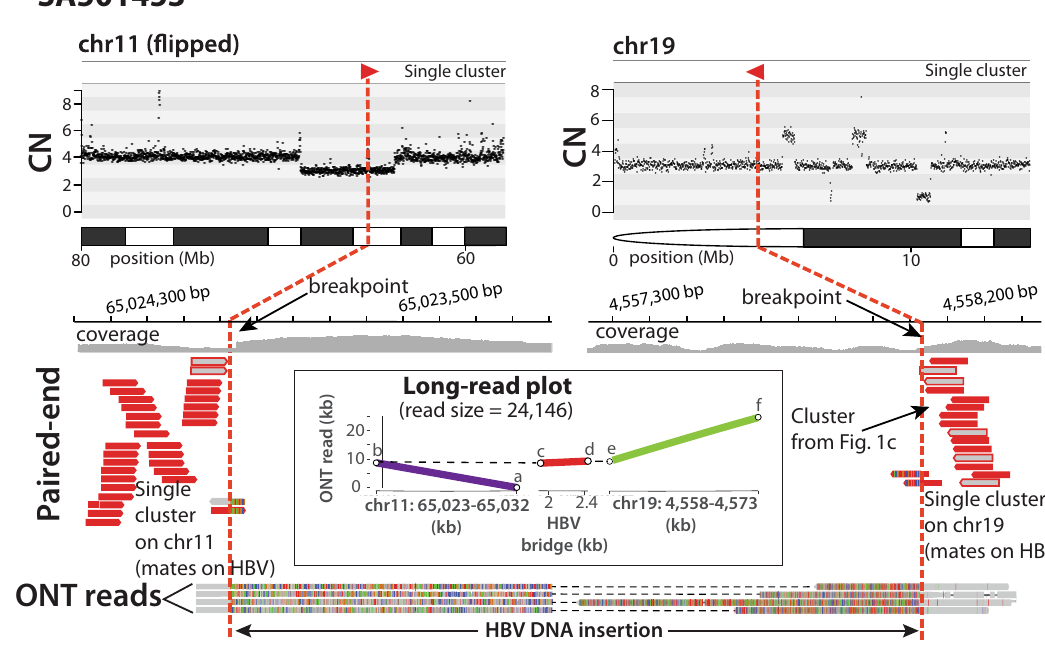
Fig. 2 Long-read sequencing reveals cryptic HBV-mediated translocations in human HCC. In HCC SA501453, a hidden interchromosomal rearrangement between chromosomes 11 and 19 is identi fi ed using Oxford Nanopore Technologies (ONT). The copy number plot (CN) at the top shows the copy number pro fi les of the chromosomes involved in the rearrangement (note that the CN plot on chromosome 11 is fl ipped for illustrative purposes). The Illumina paired-end sequencing data (short-reads in red) shows two single clusters of discordant read pairs, one on 11q and a second on 19p, pointing to HBV insertion events that cannot be bridged due to Illumina library size constrains. The bottom shows four long-reads obtained with ONT that reveals the real con fi guration of the hidden rearrangement, consisting of a 640 bp HBV DNA insertion bridging a translocation between 11q and 19p. ONT reads were cut (discontinued) for illustrative purposes. The long-read plot represents the alignment of one ONT read – 24 kb long – to chromosomes 11 and 19 of the human reference genome and to an HBV consensus sequence. The long-reads used to construct the long-read plots are annotated in